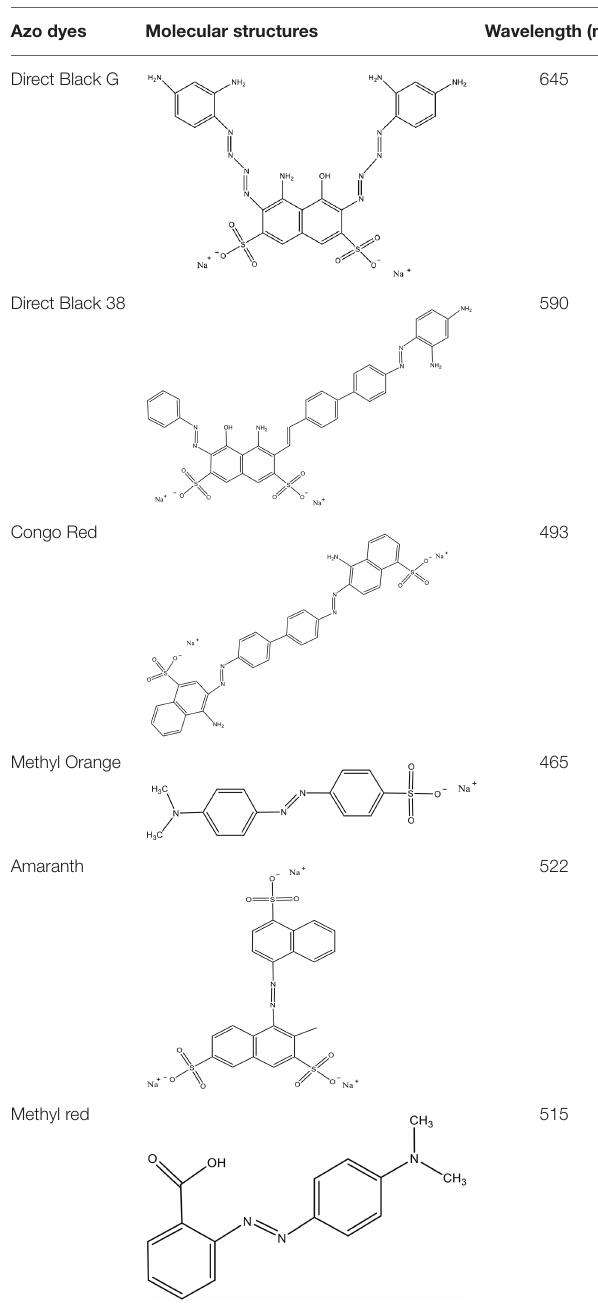
TABLE 1 | Characteristics of the main azo dyes used in this study. Azo dyes Molecular